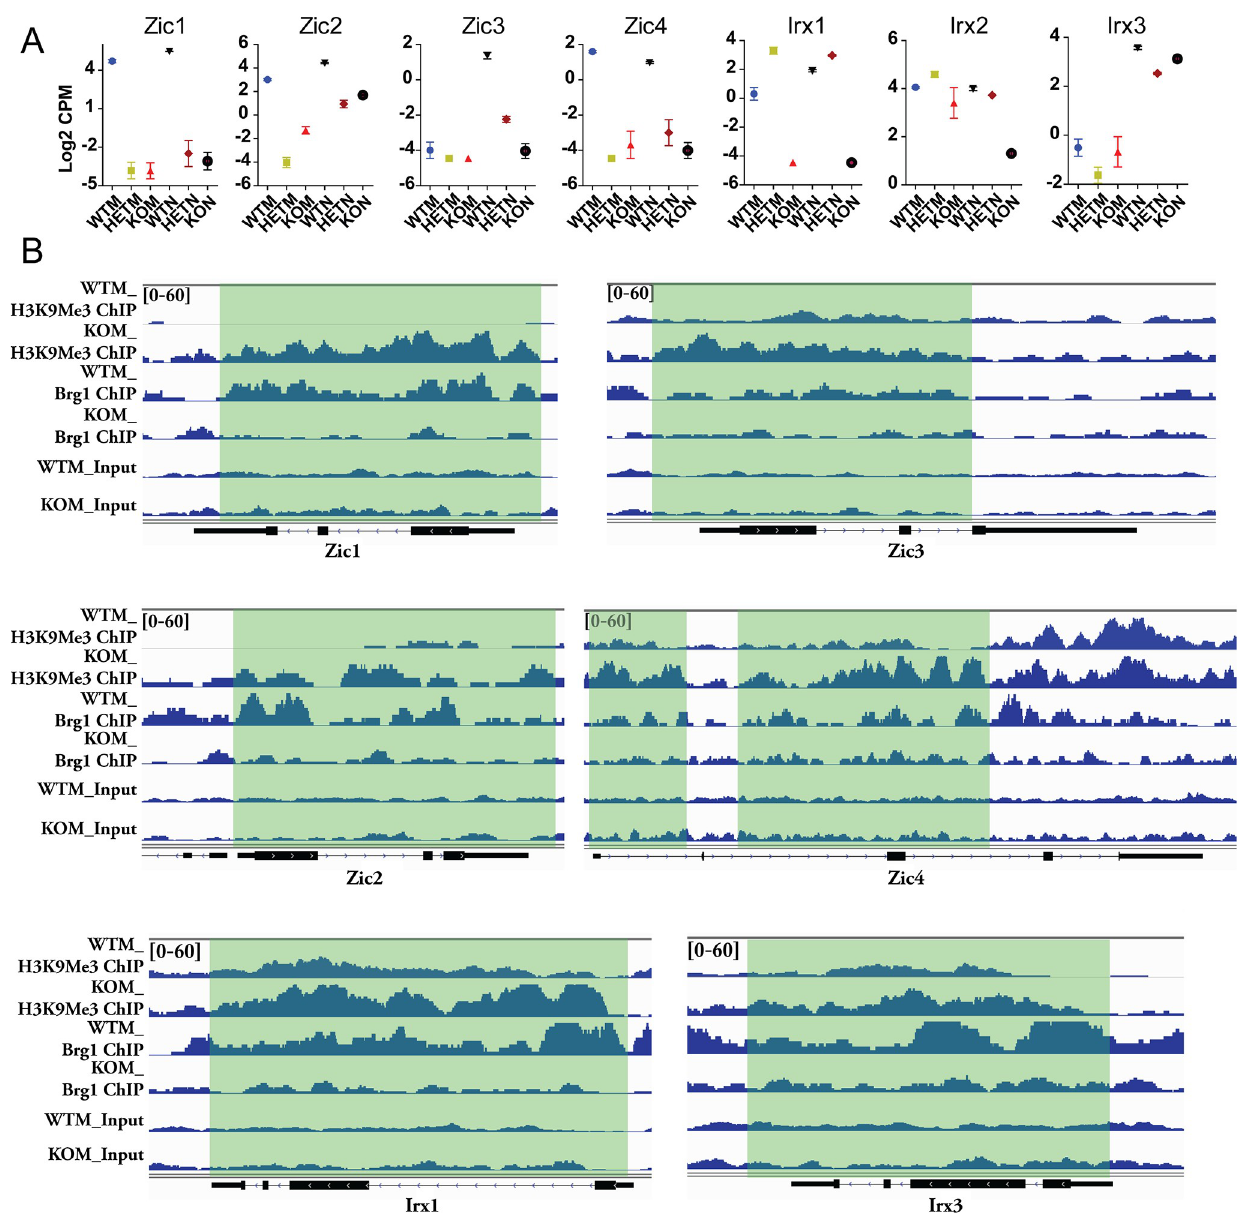
Fig 6. β -actin is required for the regulation of chromatin status and the expression of Zic and Irx genes in MEFs or CiNeurons. (A) The relative expression of Zic amd Irx genes in MEFs and CiNeurons. Data are summary of at least 3 biological replicates from RNA-seq analysis. Error bar: S.E.M. (B) H3K9Me3 and Brg1 ChIP-seq analysis in WTM and KOM cells at Zic and Irx loci. Normalized signal at Zic1 ; Zic2 ; Zic3 ; Zic4 ; Irx1 ; and Irx3 loci were shown. The y-axis data range represents RPKM (Reads Per Kilobase of sequence range per Million mapped reads) per bin. The y-axis of tracks in the same image were set as the same range. Gene body position (exon: box, intron: line) are shown below the tracks. Regions of each gene loci with elevated H3K9Me3 level and impaired Brg1 binding in KOM cells are highlighted.